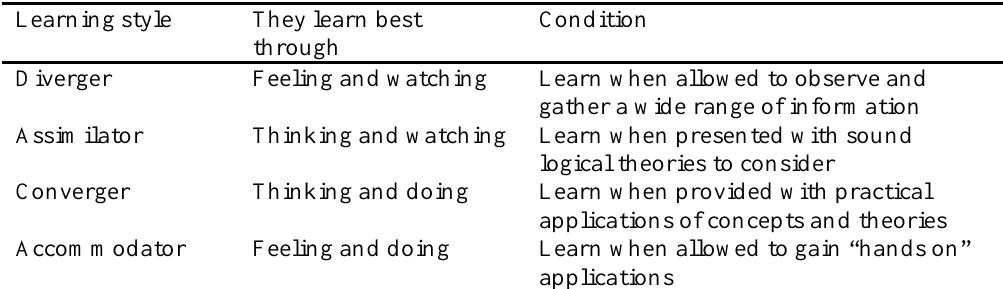
Table 1 Learning Styles and Conditions (Manochehr, 2006) Learning